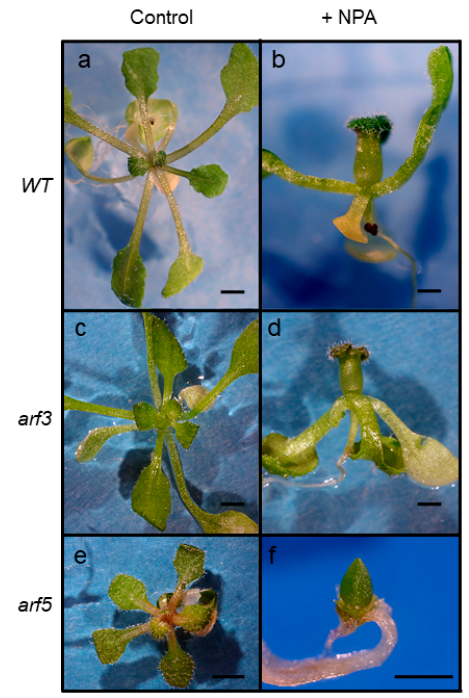
Figure 6. Leaf initiation in NPA-treated arf mutants. WT ( a ), arf3 ( c ) and arf5 ( e ) rosette of leaves when grown under control conditions. When grown in the presence of 10 µM NPA, WT ( b ), arf3 ( d ), arf7 and arf19 mutants still produce leaves and usually terminate with a tubular leaf (data not shown). mp/arf5 mutants cease forming leaves in response to NPA, resulting in a leafless dome ( f ). 21 DPI, size bars are 0.5 mm.